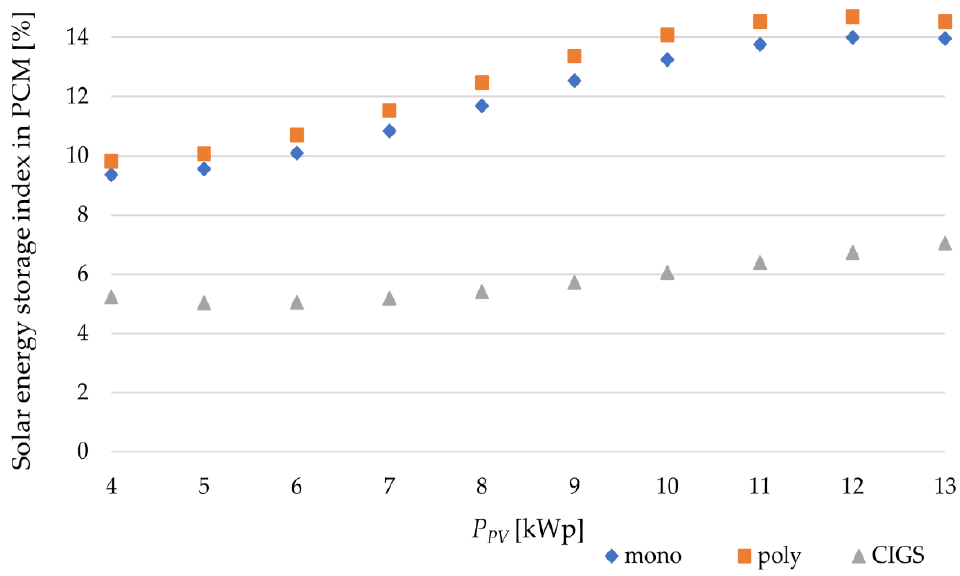
Figure 14. Solar energy storage index in PCM as a function of PV power plant power for cloudy days.